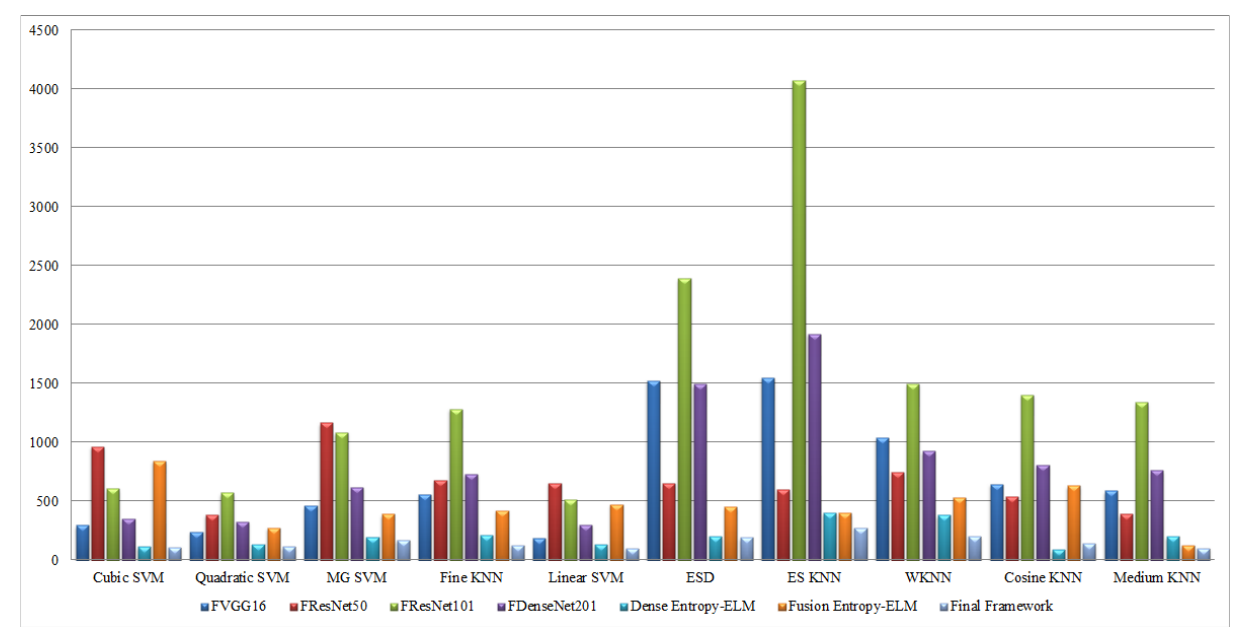
Figure 5. Confusion matrix of Cubic SVM after employing feature selection technique.